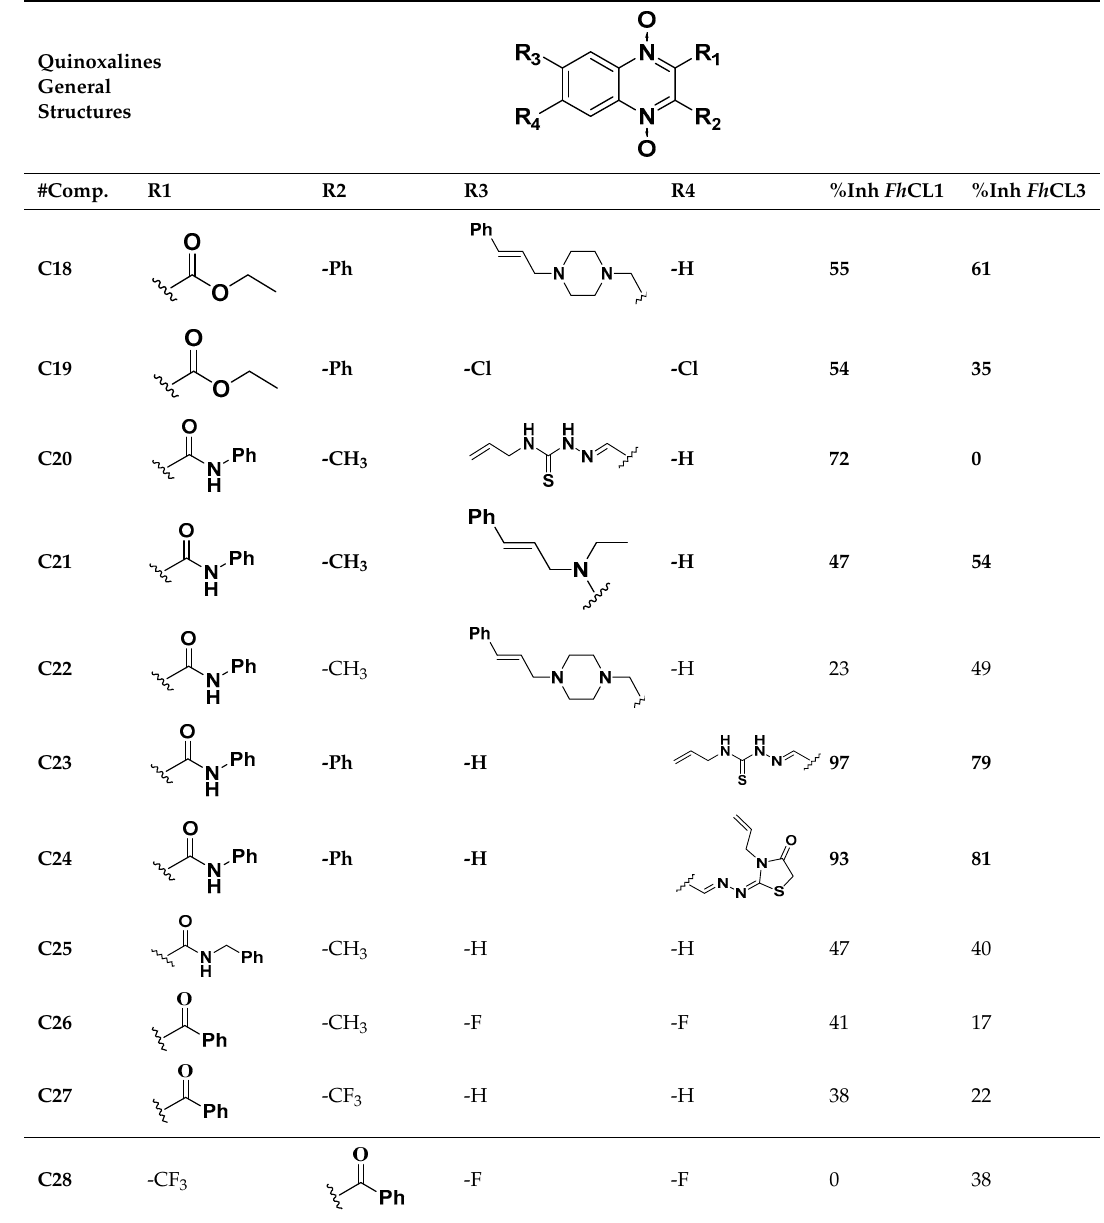
Table 1. Structures of quinoxaline 1,4-di- N -oxide derivatives evaluated as inhibitors of Fasciola